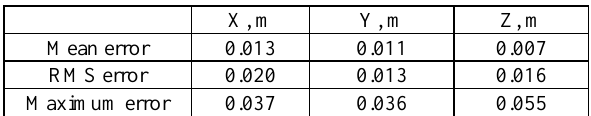
Table 3. Relative accuracy estimation of MLS data adjustment using check points